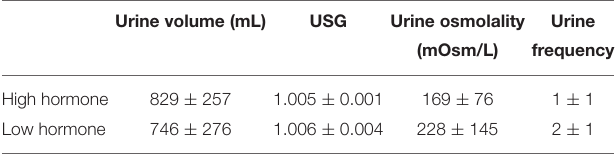
Frontiers in Sports and Active Living |